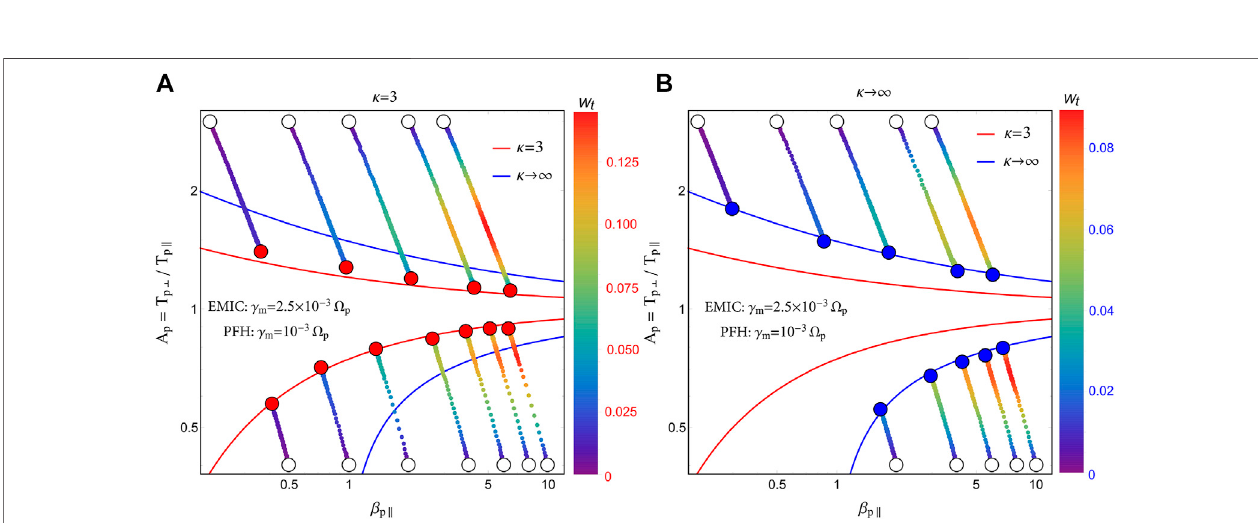
Frontiers in Astronomy and Space Sciences |